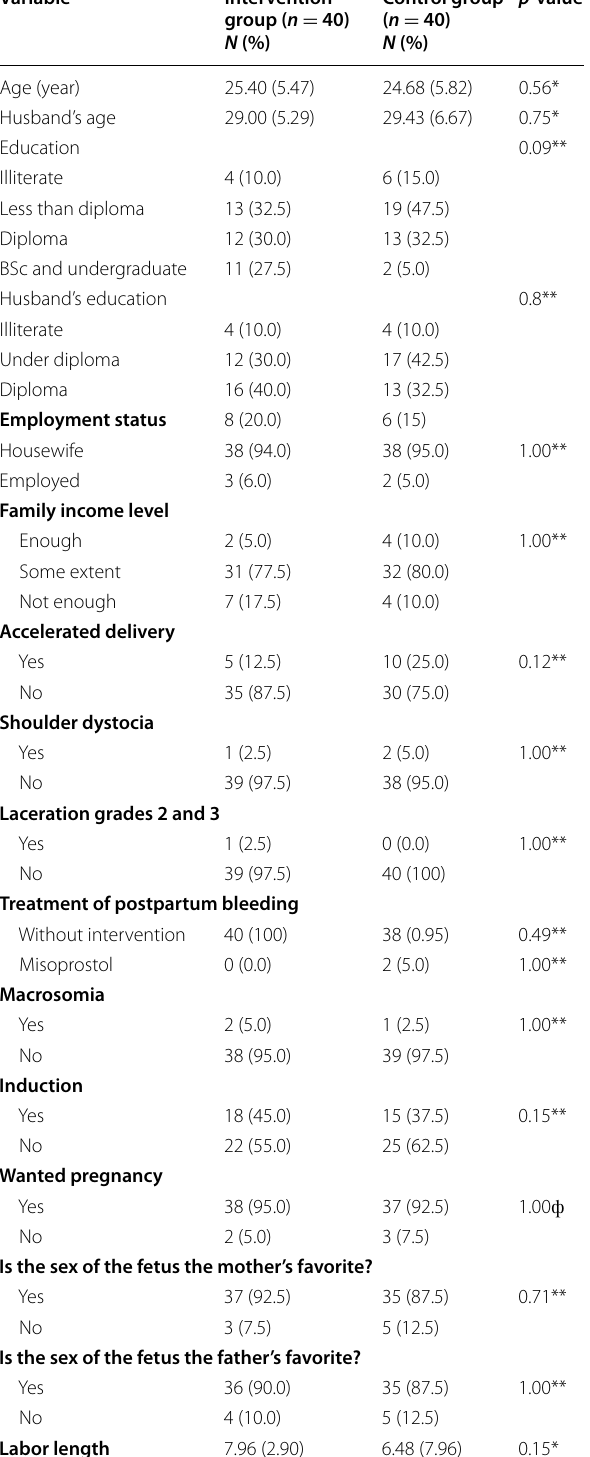
Table 1 Demographic and obstetric charasteristic of parturient women ( n 80) in the studied groups (Talesh, Iran, =